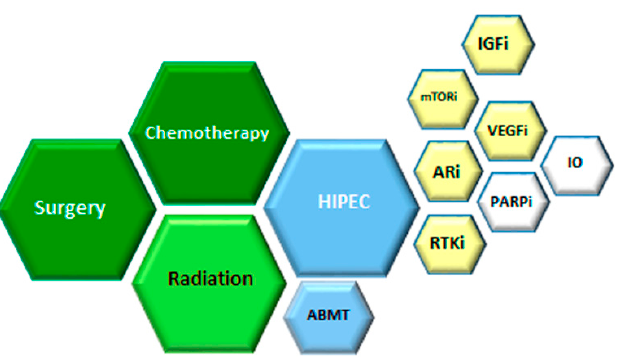
Figure 1. Therapeutic options for desmoplastic small round cell tumor (DSRCT). Based on multiple retrospectives and few prospective studies, the benefit was observed for therapies in green, low evidence of the benefit for therapies in blue. For relapsed or progressive disease, strategies in yellow had been used and in white are perspectives. HIPEC (hyperthermic intraperitoneal chemotherapy), RTKi (Receptor Tyrosine Kinase inhibition), ARi (Androgen Receptor inhibition), VEGFi (Vascular Endothelial Growth Factor inhibition), IO (immune check point inhibition), IGFi (Insulin Growth Factor inhibiotion), mTORi (mammalian Target of Rapamycin inhibition), ABMT (autologous bone marrow transplant).